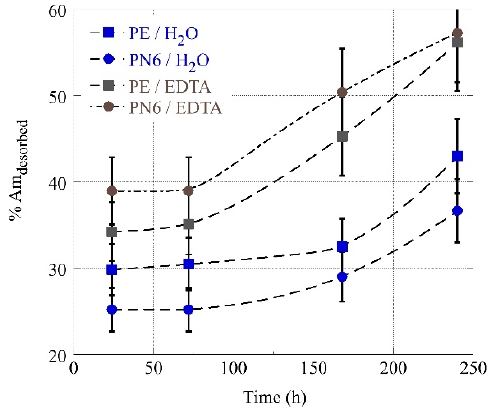
Figure 5. Relative amount of Am(III) desorbed from PE and PN6 microplastics in laboratory deion- ized and 0.001 M EDTA solutions, as function of time.